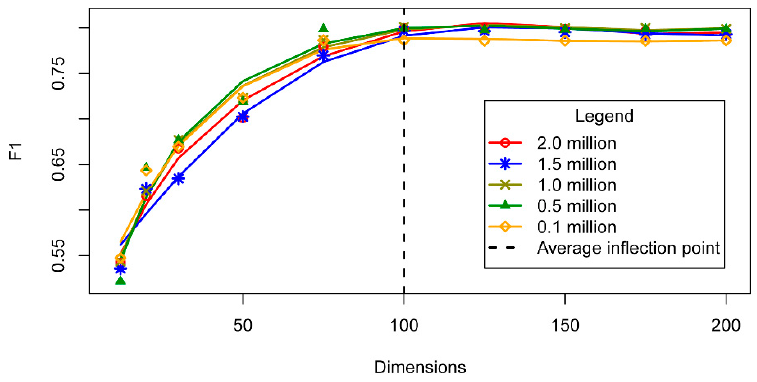
Figure 7. The relationship between the vector dimension and F1 value.